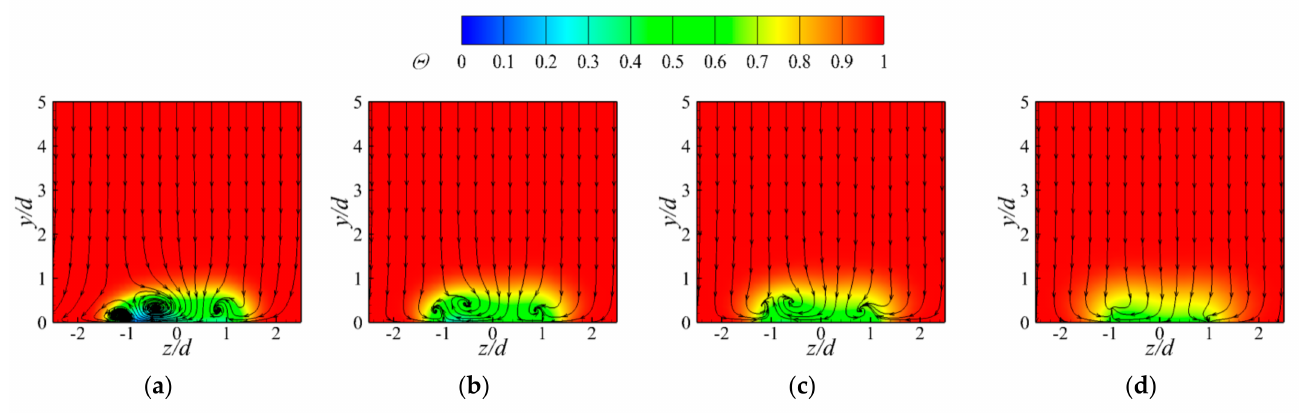
Figure 7. Dimensionless temperature contours and streamlines in downstream normal sections on the pressure side for DJFC under M = 0.5. ( a ) s / d = 3, ( b ) s / d = 6, ( c ) s / d = 9, ( d ) s / d = 15.